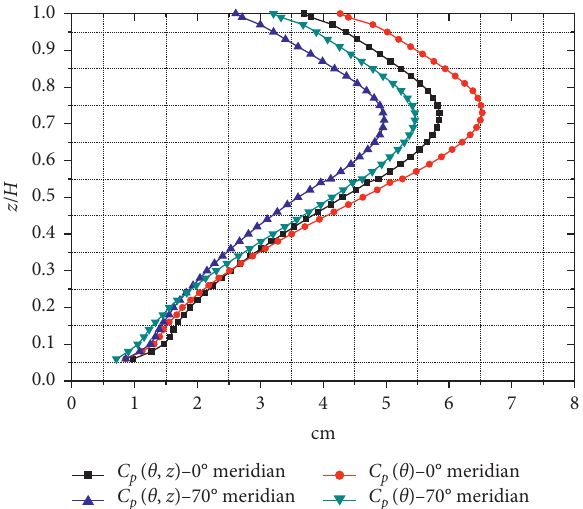
Figure 10: Comparison of